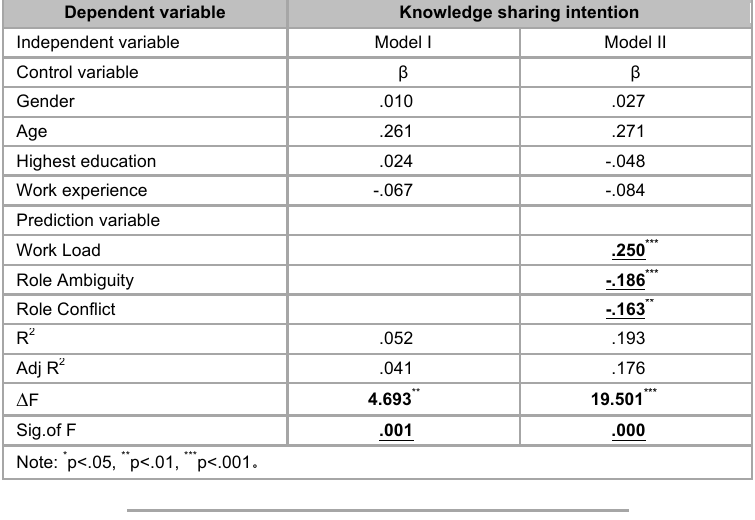
Regression analysis of the moderating effects of Colour on the relations